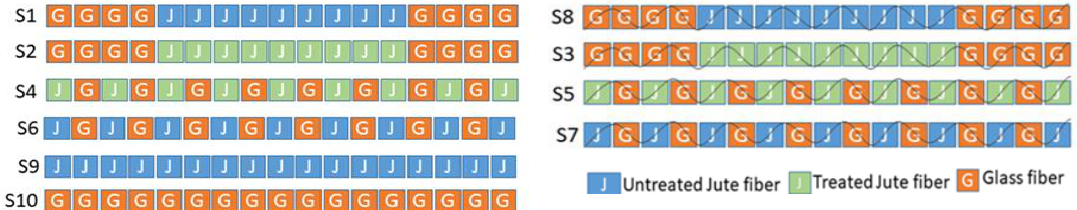
Figure 2: Different fibre sequence and composite ID. Right side composites are with micro filler